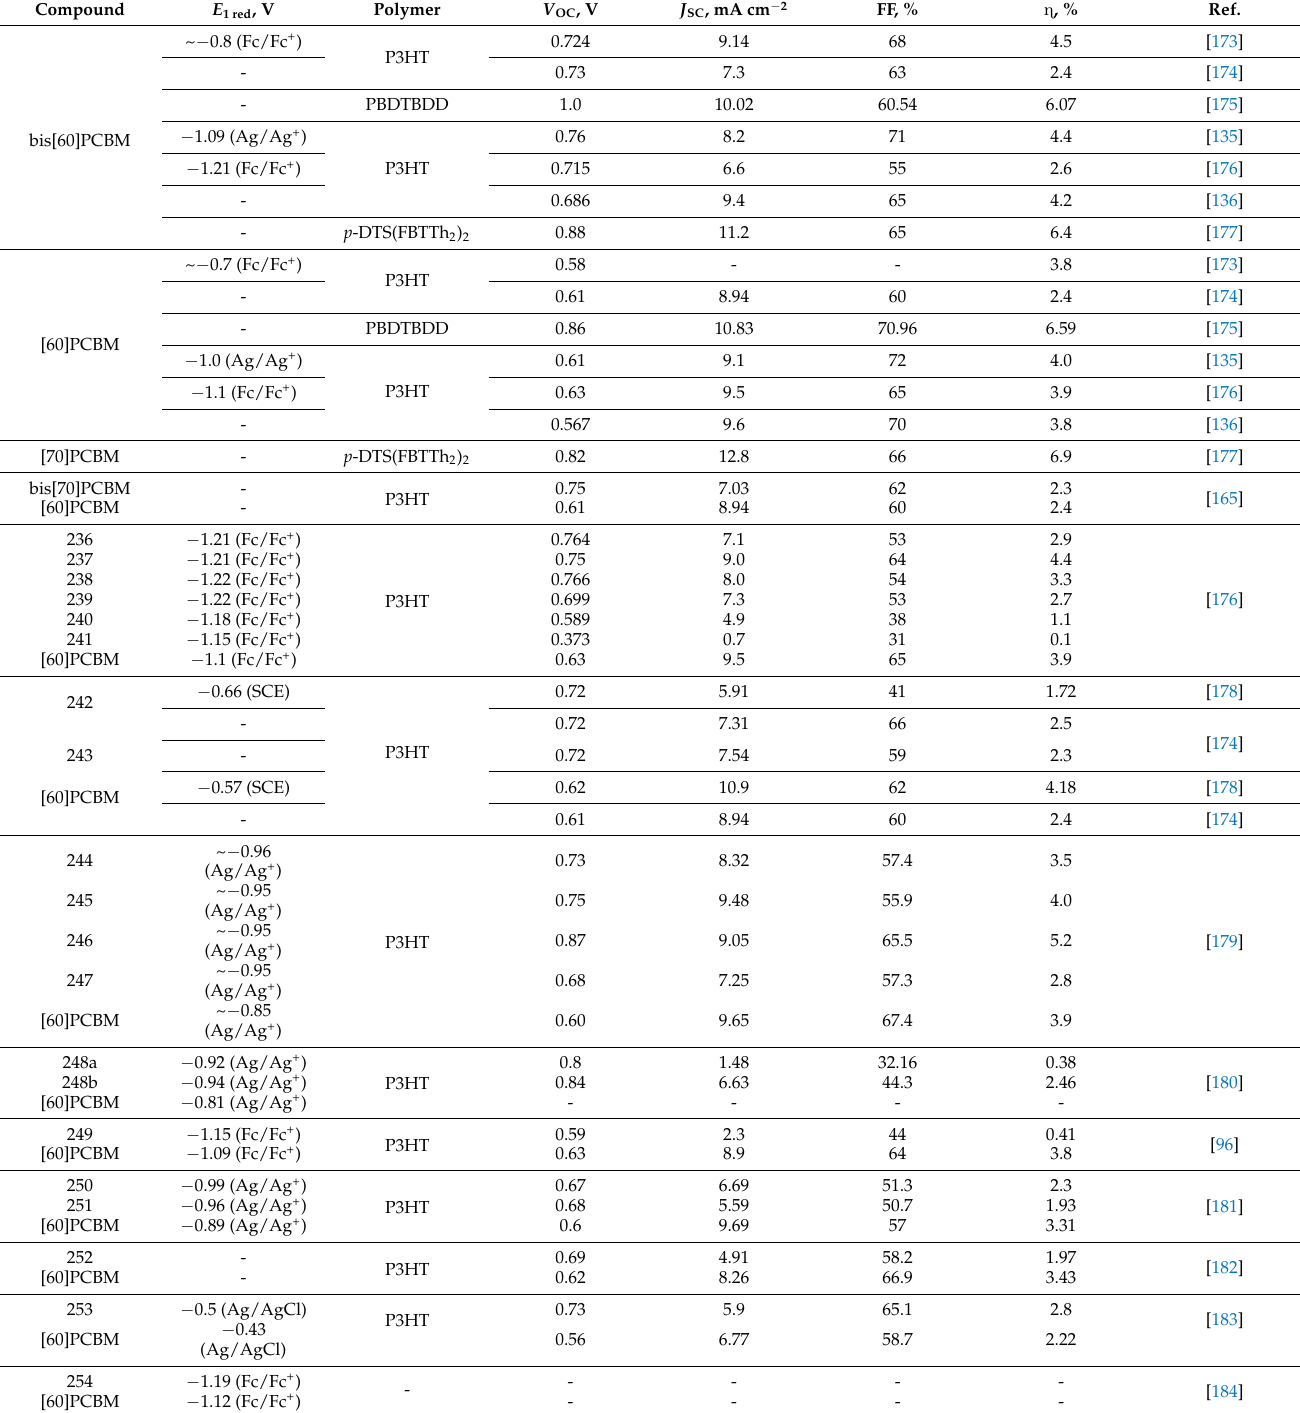
Table 8. First reduction potentials and the characteristics of solar cells based on the bis(cyclopropane) fullerene